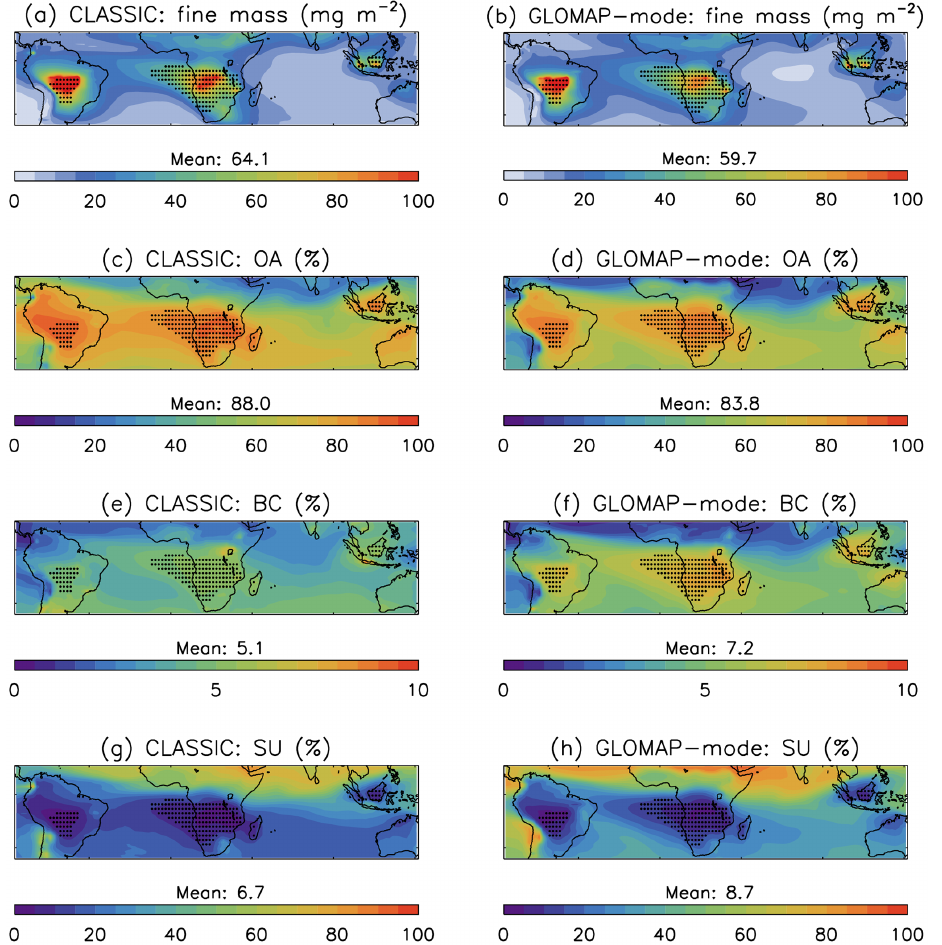
Figure 6. Modelled fine-mode aerosol composition from HadGEM3 for CLASSIC and GLOMAP-mode (including sulfate, BC, and OA only). Plots show (a, b) fine-mode mass burden (mgm − 2 ) , (c, d) mass fraction of OA (%), (e, f) mass fraction of BC (%), and (g, h) mass fraction of sulfate (%). Stipples indicate grid columns where more than 75% of the fine-mode aerosol mass originates from biomass burning emissions (based on the speciation in the CLASSIC simulation). Mean values beneath each plot give the average from grid columns marked by these